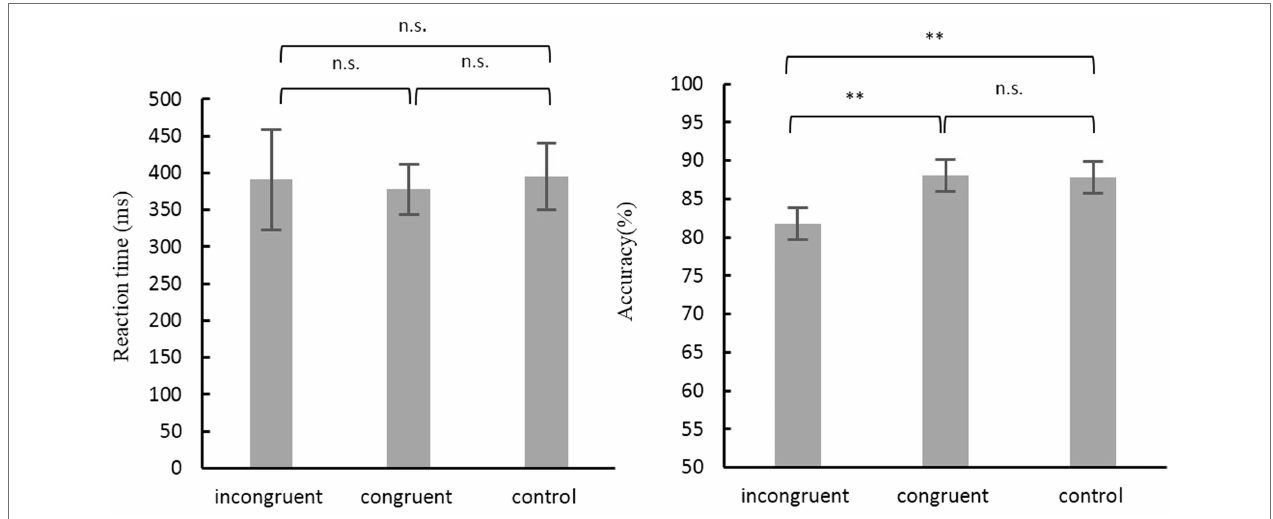
FIGURE 1 | Accuracy and Reaction time for different conditions in Simon task. Error bars depict SD. n.s., not significant; ** p <